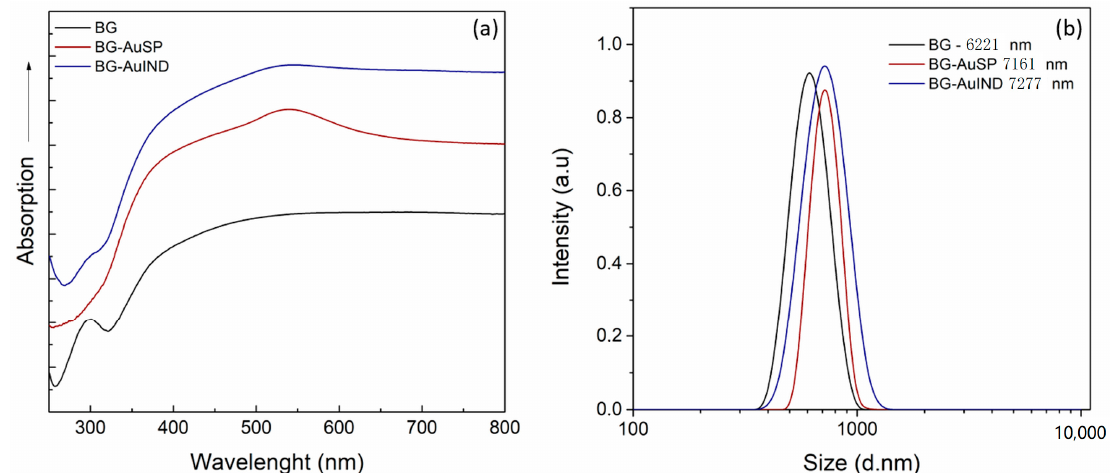
Figure 1. UV-Vis absorption spectra of the BG, BG-AuSP and BG-AuIND composites ( a ) and particle size distributions of BG, BG-AuSP and BG-AuIND measured by DLS (dynamic light scattering) ( b ).